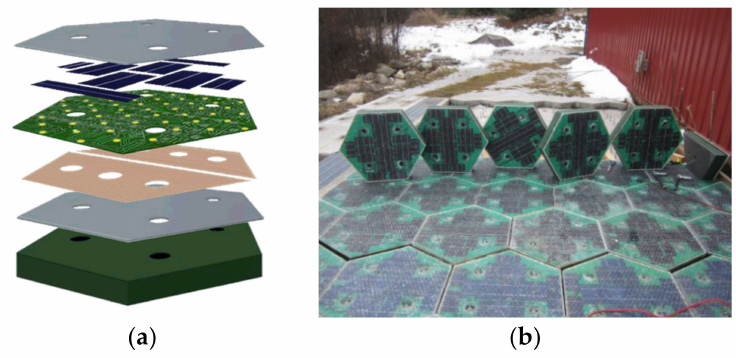
Figure 2. SR2 prototype; ( a ) schematic drawing; ( b ) actual panel (Brusaw,